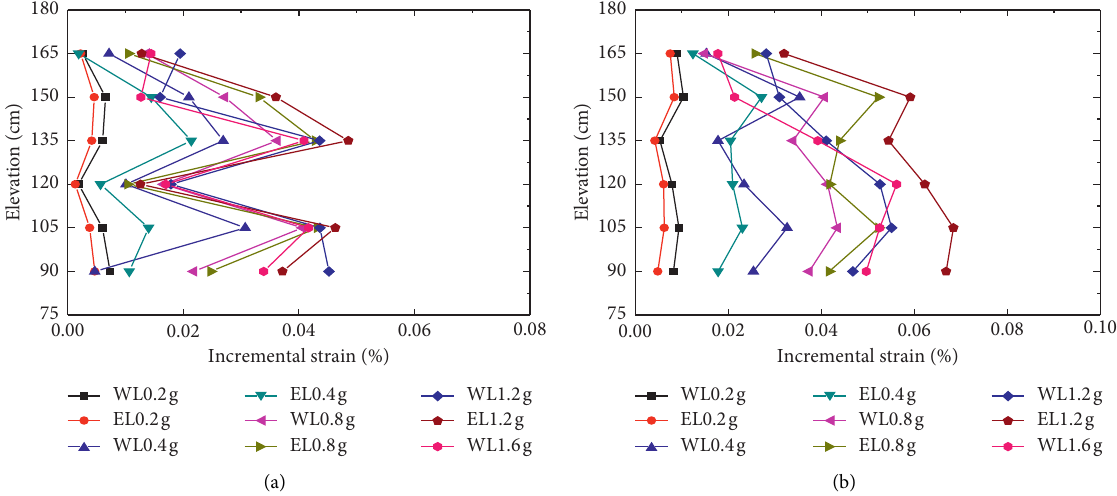
Figure 12: Distributions of strain in T 2 and T 3 for specimen 1. (a) T 2. (b) T 3.